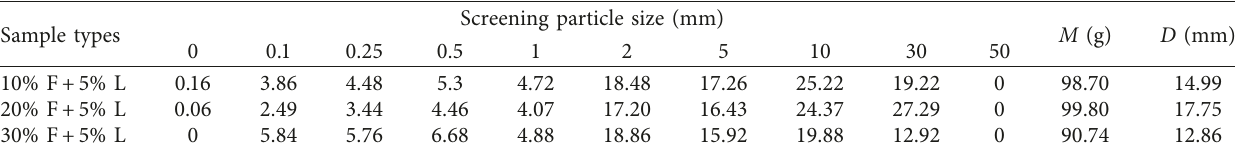
Figure 9: Fracture morphology of stabilized soil under different mix proportions. (a) Plain soil; (b) 10% F stabilized soil; (c) 20% F stabilized soil; (d) 30% F stabilized soil; (e) 10% F+5% L stabilized soil; (f) 20% F+5% L stabilized soil; (g) 30% F+5% L stabilized soil. Table 3: Screening results of impact fragments of stabilized soil in the SHPB